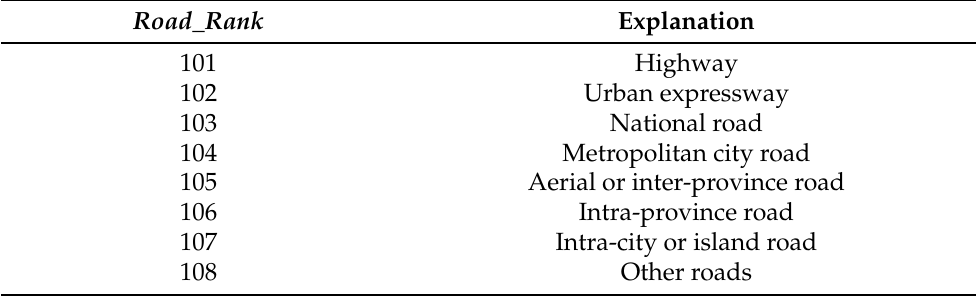
Table 2. The road_rank attribute in the NLM.